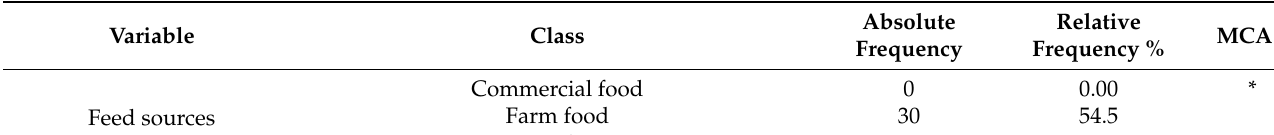
Table 4. Characteristics of the scope of use of local resources in feeding livestock on pig farms in communities of Jipijapa (N =